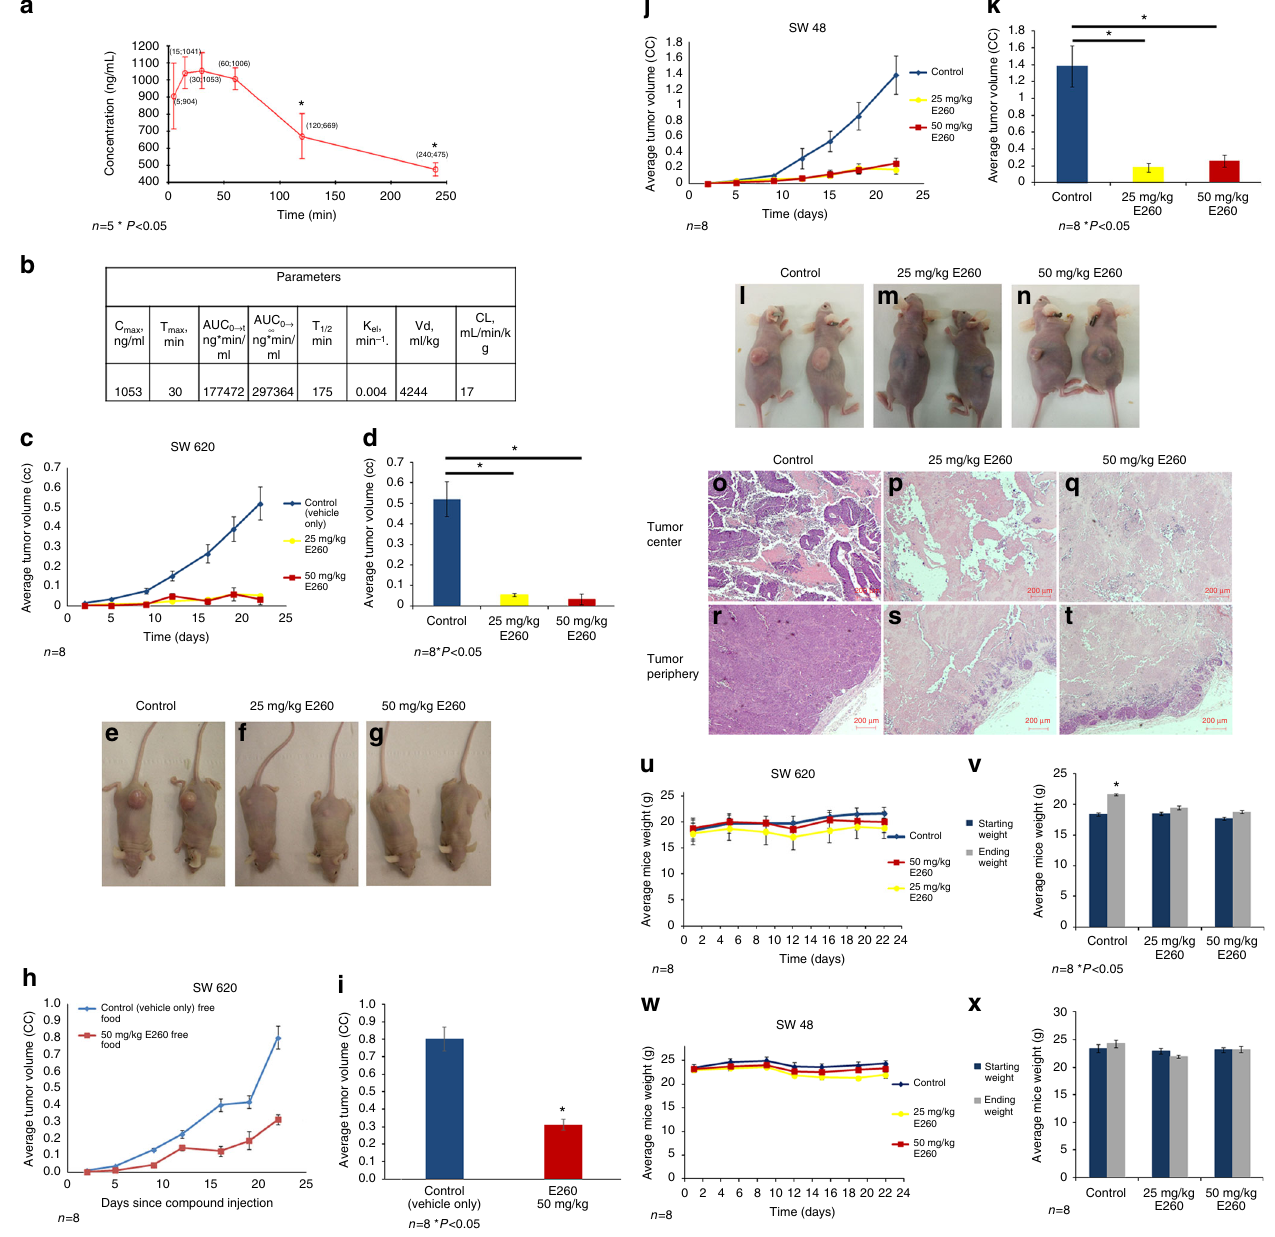
Fig. 7 Systemic E260 treatment attenuates CC xenograft progression in immuno-compromised mice. a PK analysis of E260 in mice blood following IP administration of the compound; n = 5 for each time point. b Summary table for E260 PK parameters and distribution in vivo. c Tumor progression in mice bearing SW620 derived xenografts fed with restricted diet and injected IP twice a day with control vehicle, 25 mg/kg E260, or 50 mg/kg E260; n = 8, ± SE. d Average tumor volume after 22 days of treatment: control ( blue ), 25 mg/kg E260 ( yellow ), and 50 mg/kg E260 ( red ); n = 8, ± SE. e – g Representative images of mice bearing SW620 xenografts at day 22 post injection. h Tumor progression in mice bearing SW620 derived xenografts fed with ad libitum diet and injected IP twice a day with vehicle or 50 mg/kg E260; n = 8, ± SE. i Average tumor volume after 22 days of treatment with vehicle ( blue ) or 50 mg/kg E260 ( red ); n = 8, ± SE. j progression in mice bearing SW48 xenografts and injected IP twice a day with vehicle, 25 mg/kg E260, or 50 mg/kg E260; n = 8, ± SE. k Average tumors volume after 22 days of treatment: control ( blue ), 25 mg/kg E260 ( yellow ) and 50 mg/kg E260 ( red ); n = 8, ± SE. l – n Representative images of mice bearing SW48 xenografts at day 22 post injection. o – t Representative images of tumor sections dissected from mice at day 22 of treatment with control (vehicle only) ( o , r ), 25 mg/kg E260 ( p , s ), or 50 mg/kg E260 ( q , t ). Bars represent 200 µ m. u , w Weight pro fi les of mice bearing SW620 ( u ) or SW48 ( w ) xenografts and IP injected twice a day with control, 25 mg/kg E260, or 50 mg/kg E260; n = 8, ± SE. v , x Average starting weights and end-point weights of mice bearing tumors derived from SW620 ( v ) or SW48 ( x ) cells after 22 days of twice daily IP injection: control, 50 mg/kg E260, or 25 mg/kg E260; n = 8, ±